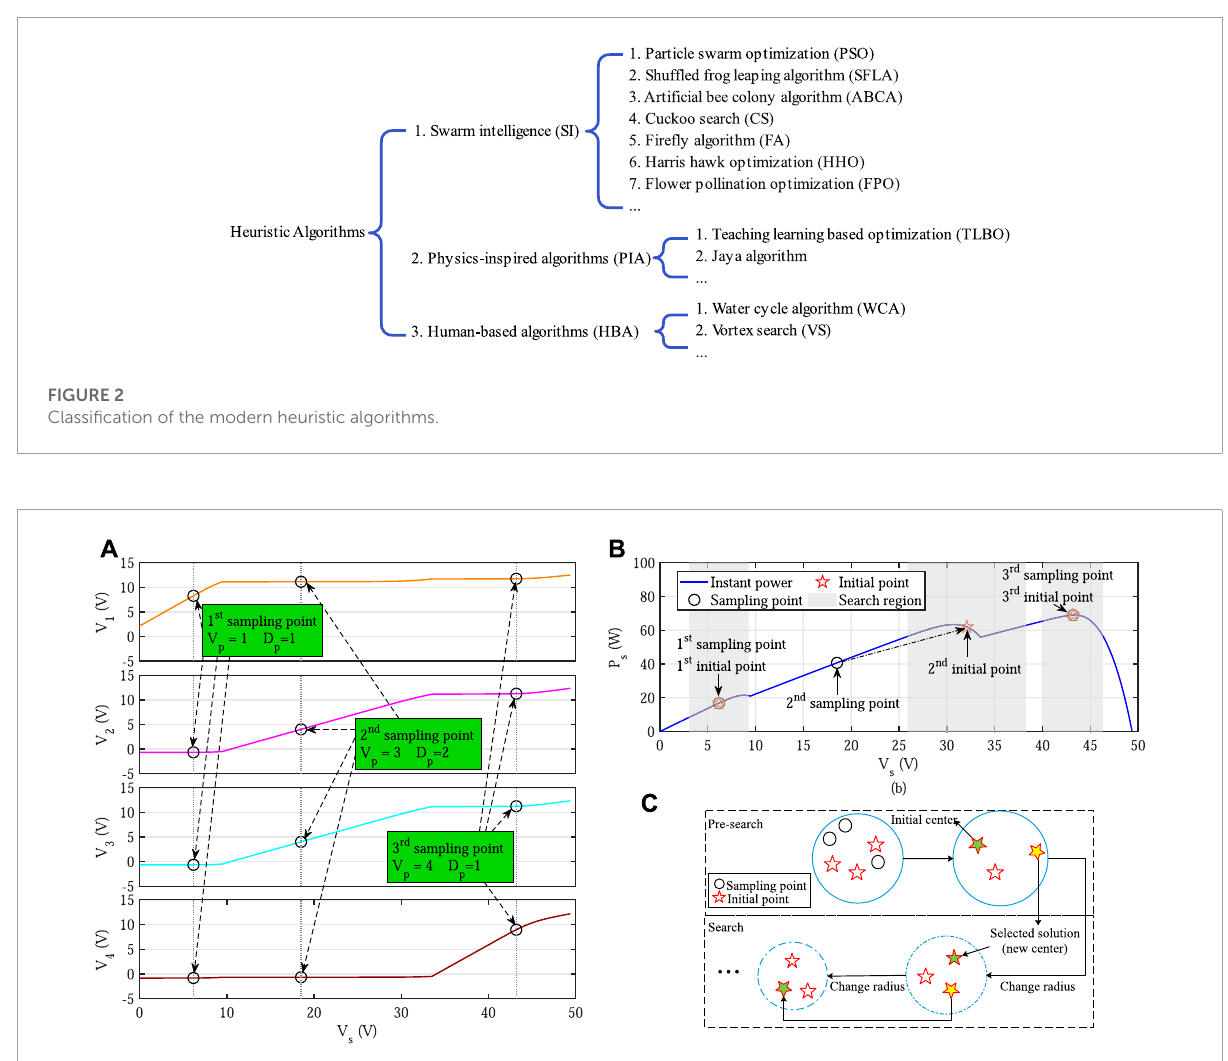
FIGURE 3 The search process of the VVS under the PSC (G1 = 1000 W/m 2 , G2 = G3 = 800 W/m 2 , G4 = 600 W/m 2 ): (A) Pre-search; (B) Determination of the initial points; (C) An illustrative sketch of the VVS optimization.